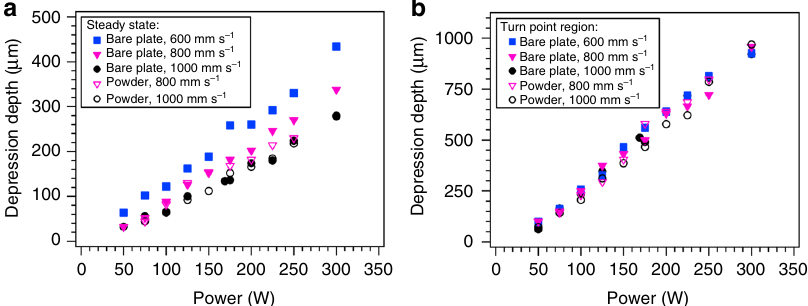
Fig. 3 Vapor depression depth during LPBF of Ti – 6Al – 4V. All laser turn conditions were performed at full laser power. a Depression depth in the steady- state scan regime where the laser is at full scan speed as a function of laser power and scan speed. b Maximum depth of the vapor depression during the laser turn as a function of laser power and set point scan speed. Note the different Y -axis scale between the two